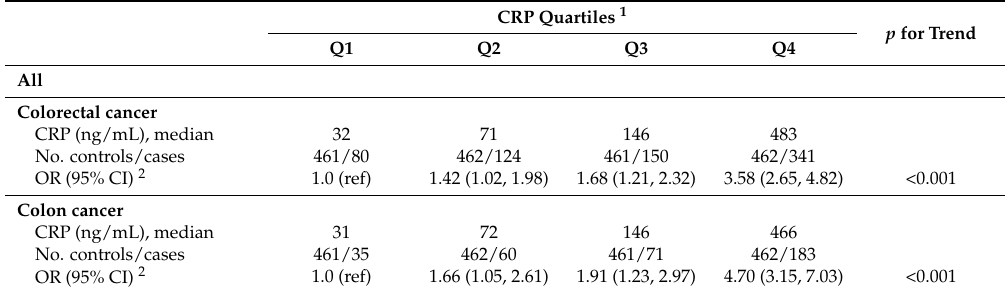
Table 2. Association between the CRP concentration and the risk of colorectal cancer stratified by sex and anatomic